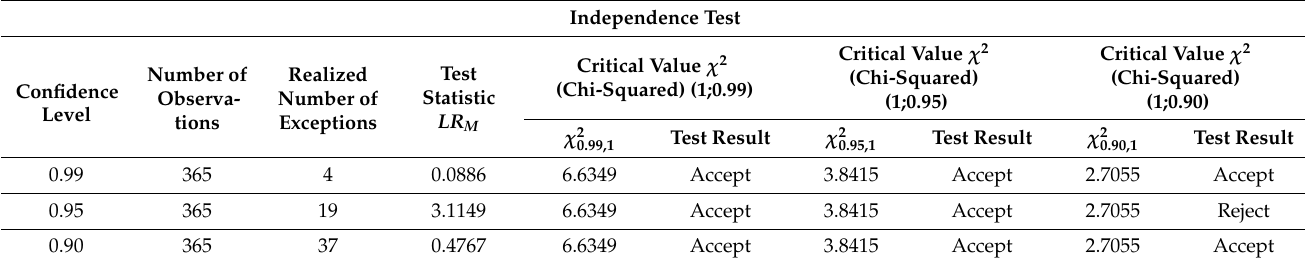
Table 4. Historical simulation VaR independence test.